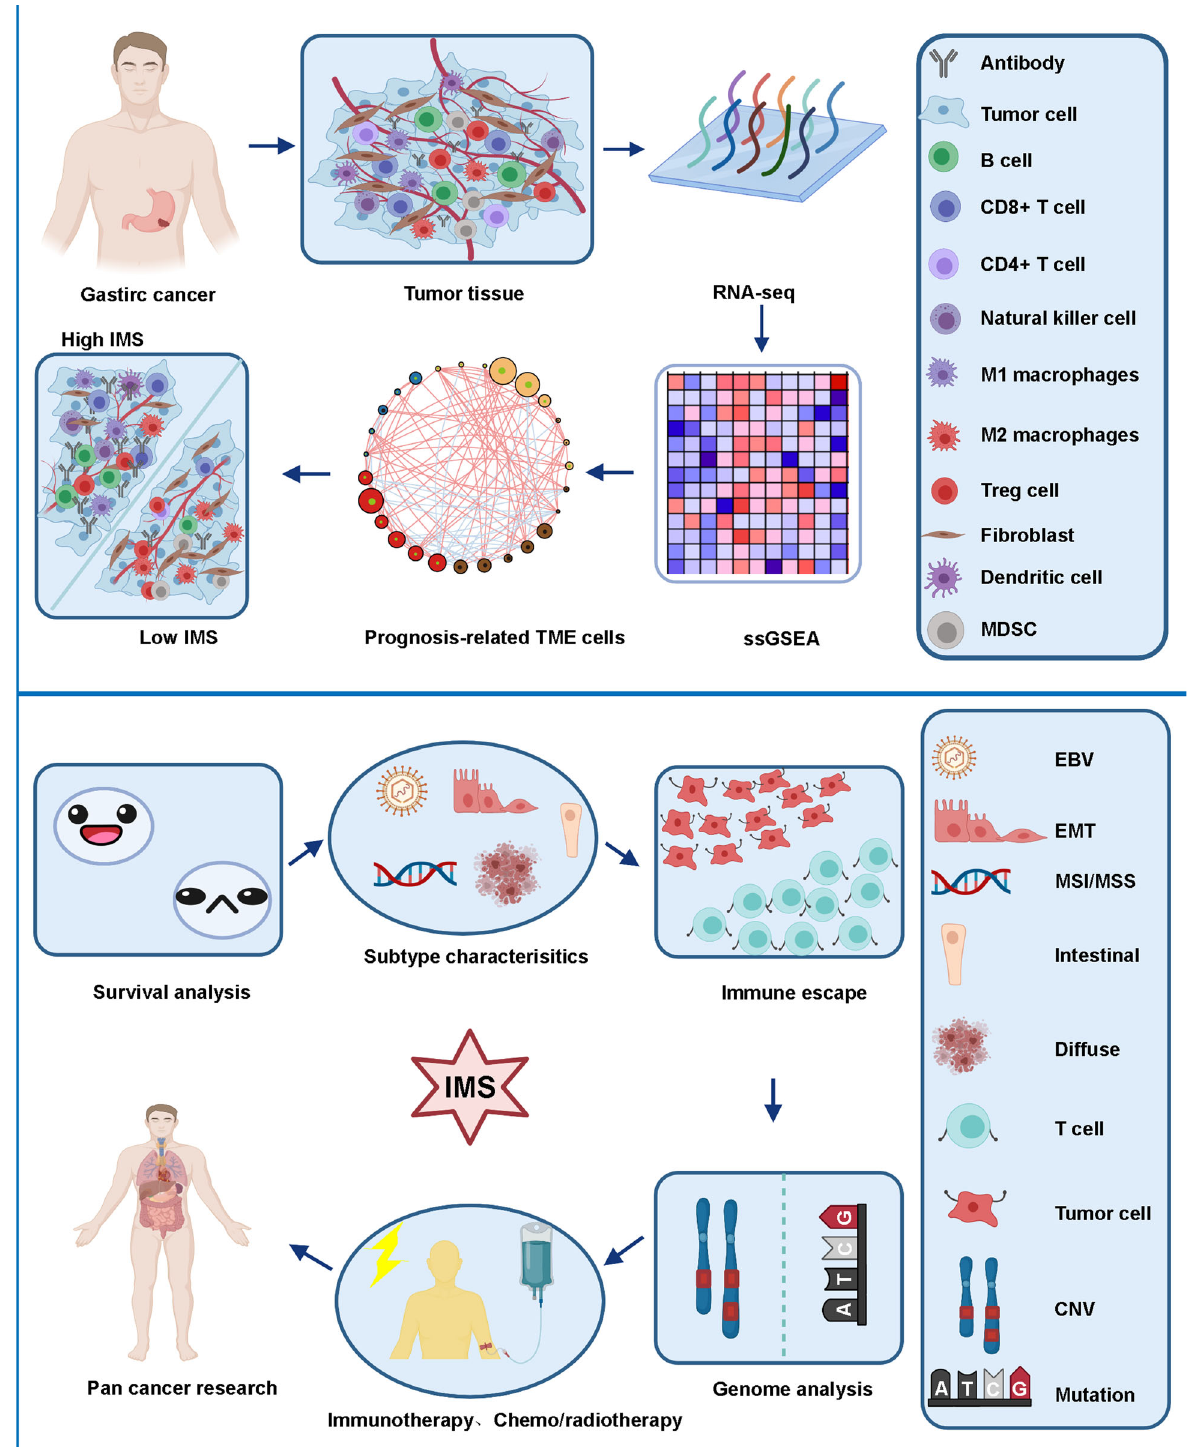
Fig. 8 The illustrations for this study. Identify gastric cancer immune subtype characteristics based on IMS and guide prognosis and treatment calculate the standardized enrichment score via the GSVA package 50 . ssGSEA ranks the gene expression values of a sample and uses the empirical cumulative distribution function of the genes in the signature and the rest of the genes to generate enrichment scores. Fifty-one TME cell signatures were collected via a literature search, and they were considered reliable 26,51 – 53 . The gene set fi le “ c2.cp.kegg.v6.2 ” was downloaded from the Molecular Signatures Database (https://www.